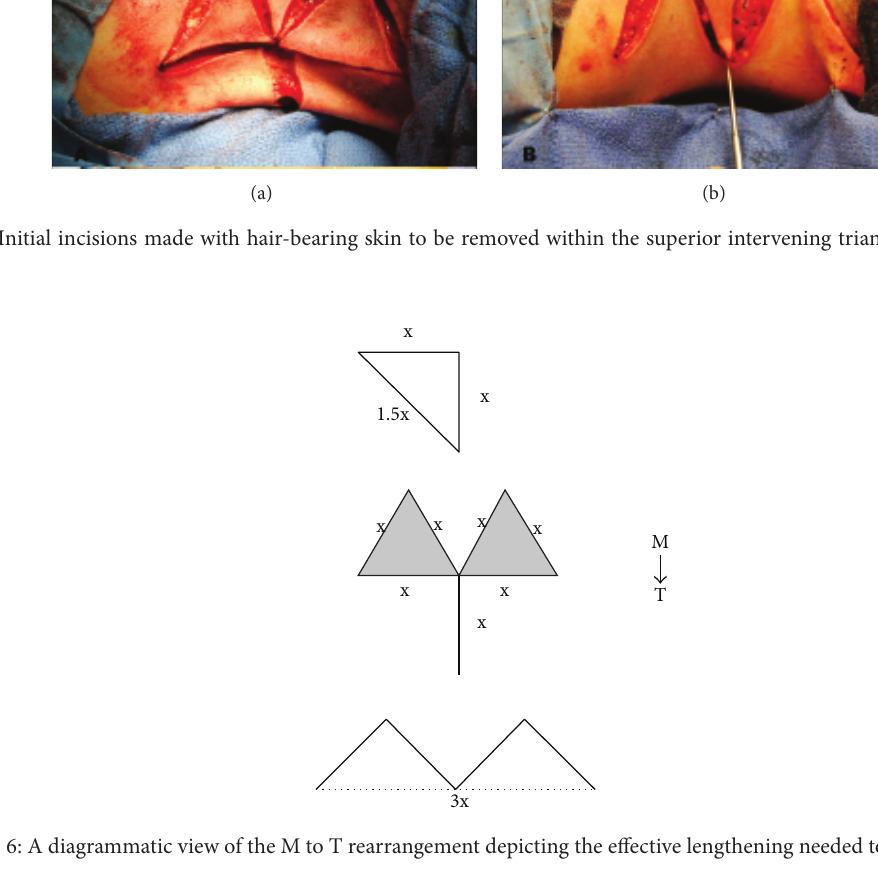
increases the incisional length, but also reduces the chances of recurrence (Figures 5 and